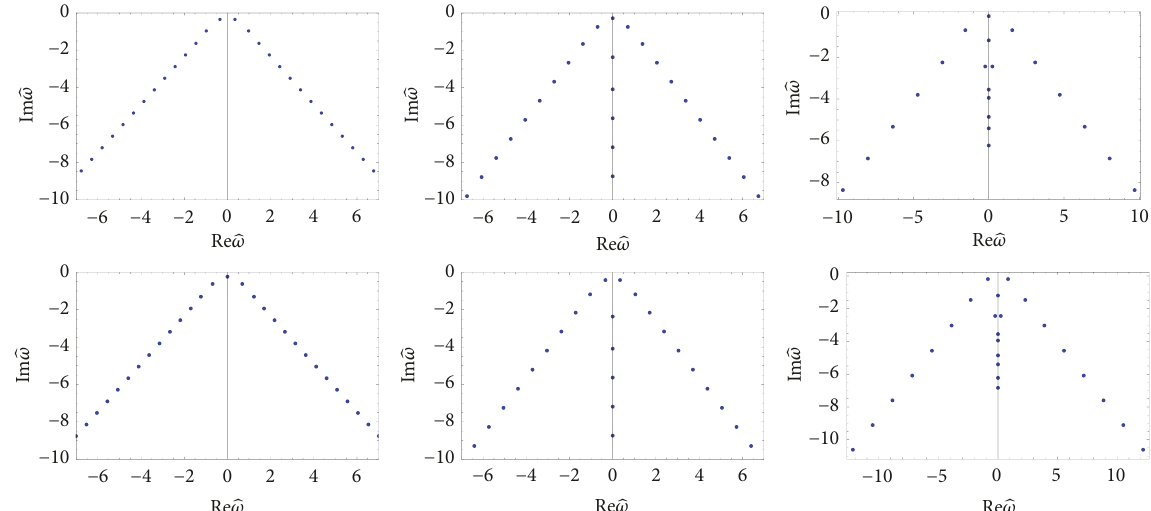
Figure 7:QNMs (blue spots) of the gaugemode for ̂𝛼 = 1/2 . Thefirst,second, and third columns are for 𝛾 1 = 0.02 , −0.02 , and −1 , respectively. The panels above are for the gauge mode, while the ones below are for the dual gauge mode.